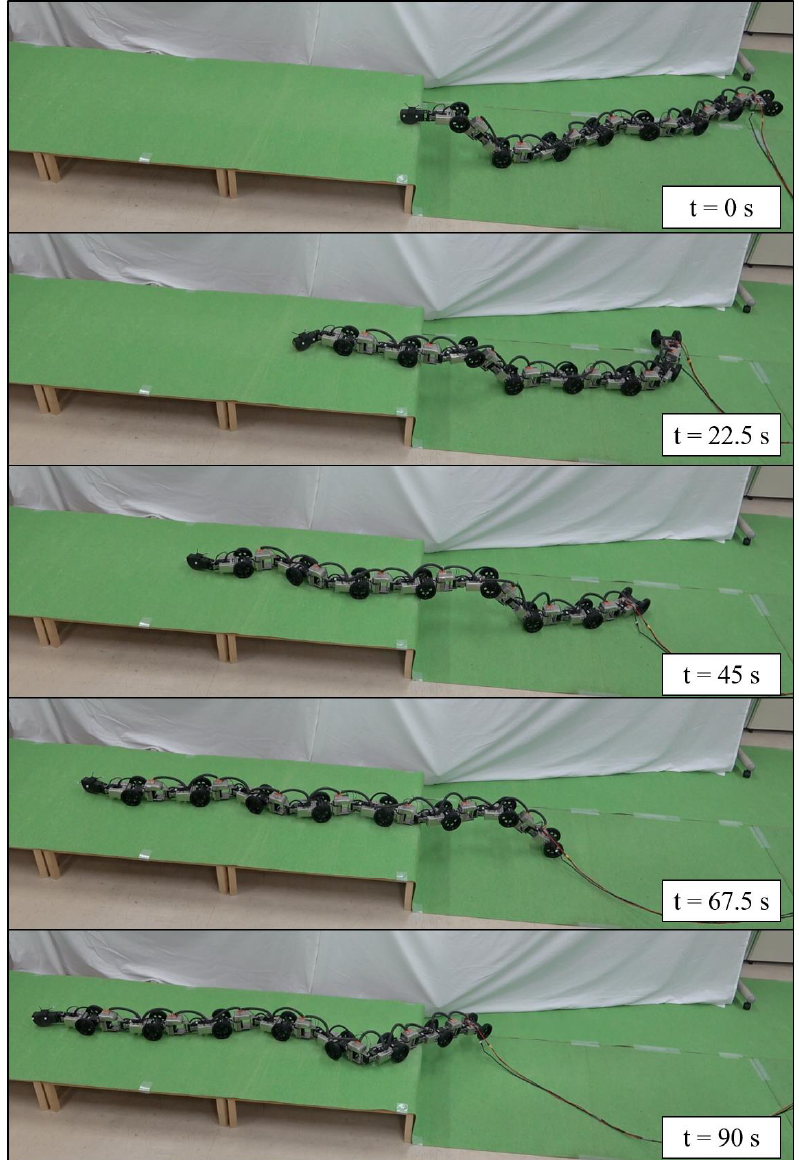
Figure 6. The robot motion in experiments. However, the error in the leading position configuration w increased after t = 70. This was caused when the bottom part of the body contacted a step. As shown in Figure 9, the prismatic joint was deformed by the load of the tail lifted in a cantilever position after the tail shift, and the bottom part of the body contacted the step and could not be moved over the step to the tail. The same reason was applied to justify why it was necessary to use a larger value 0.23 m for the step height h set during control compared with the actual value 0.20 m. To solve this problem, it is necessary to improve the rigidity of the prismatic joints so that deformation does not occur. This is one of the subjects for future